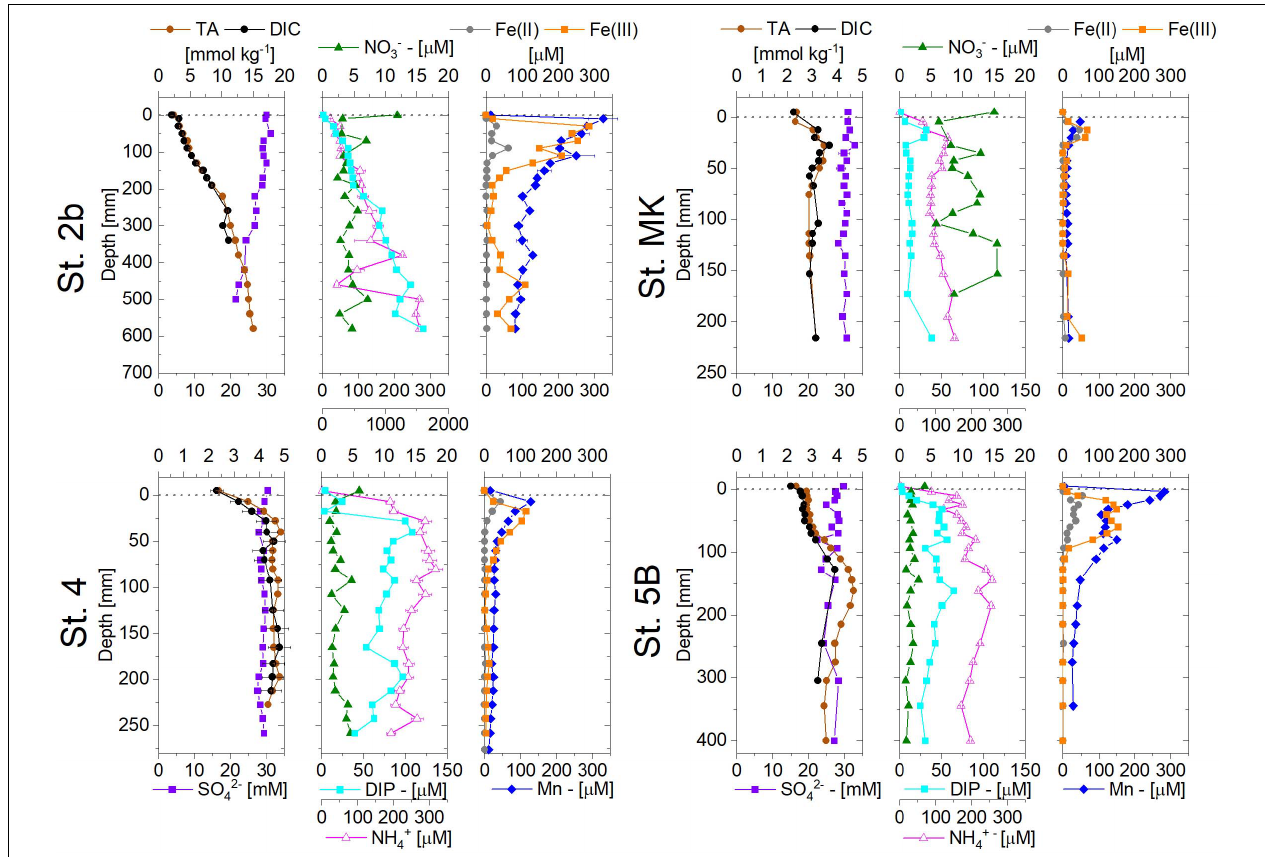
FIGURE 6 | Pore water profiles of TA, DIC, SO 42 − , NO 3 − , NH 4 + , DIP, and dissolved Mn, dissolved Fe(II), and Fe(III) obtained at the four stations on the Louisiana shelf in July-August 2017. The dashed line shows the location of the sediment-water interface. Note that Station 2b has a different depth axis (down to 700